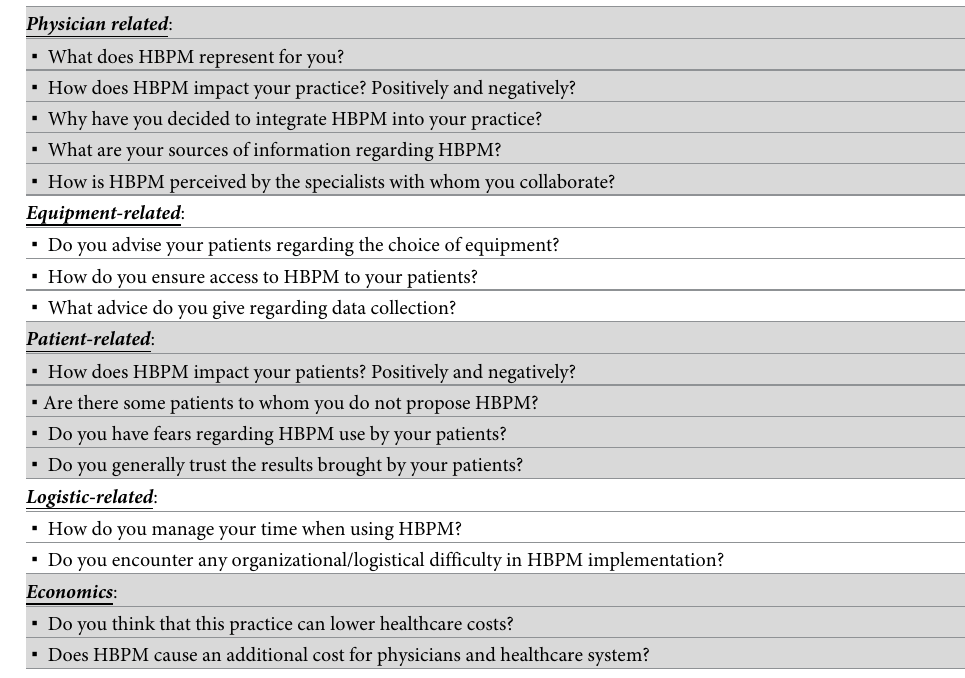
Table 1. Interview guide: Advantages and brakes linked to